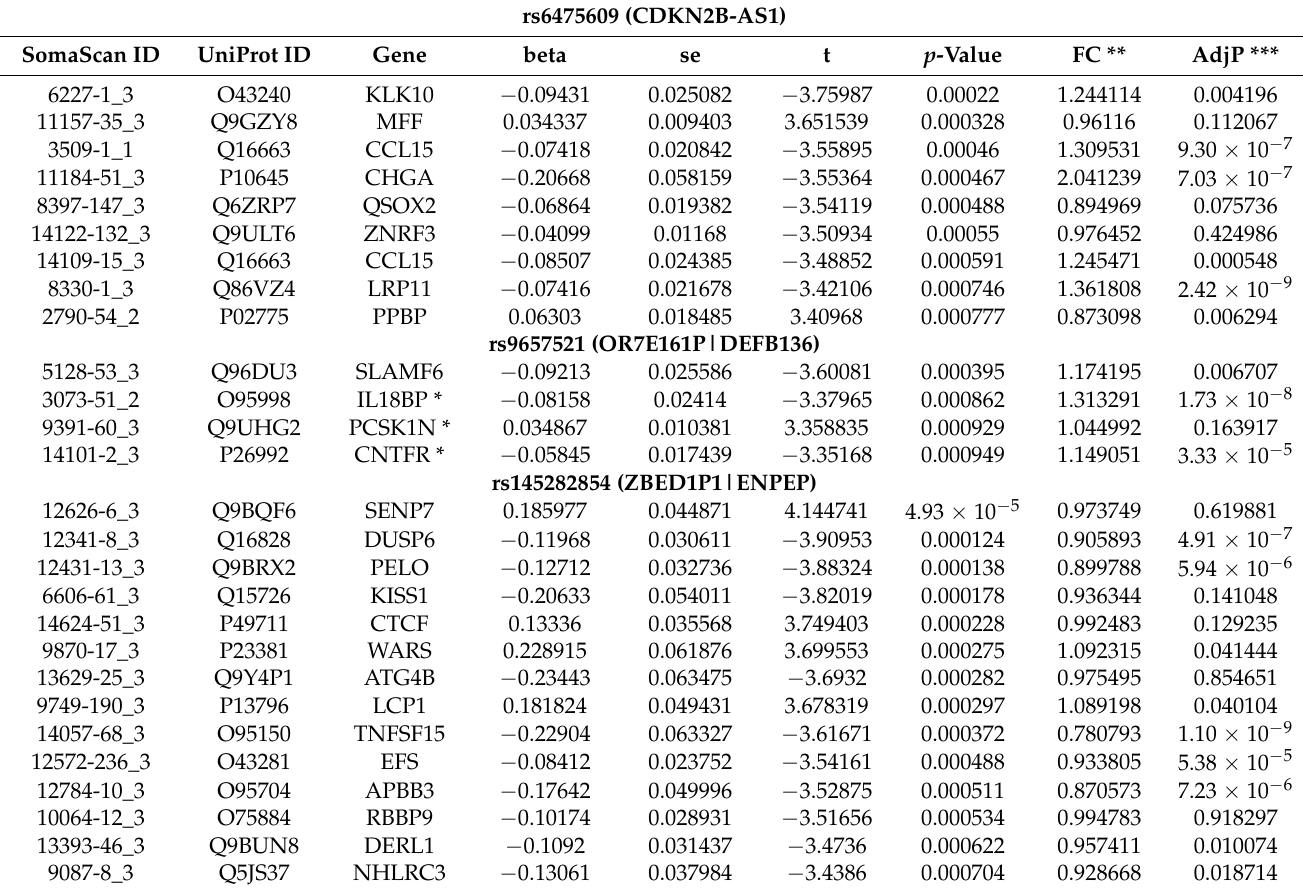
Table 2. Protein Signatures for the Top